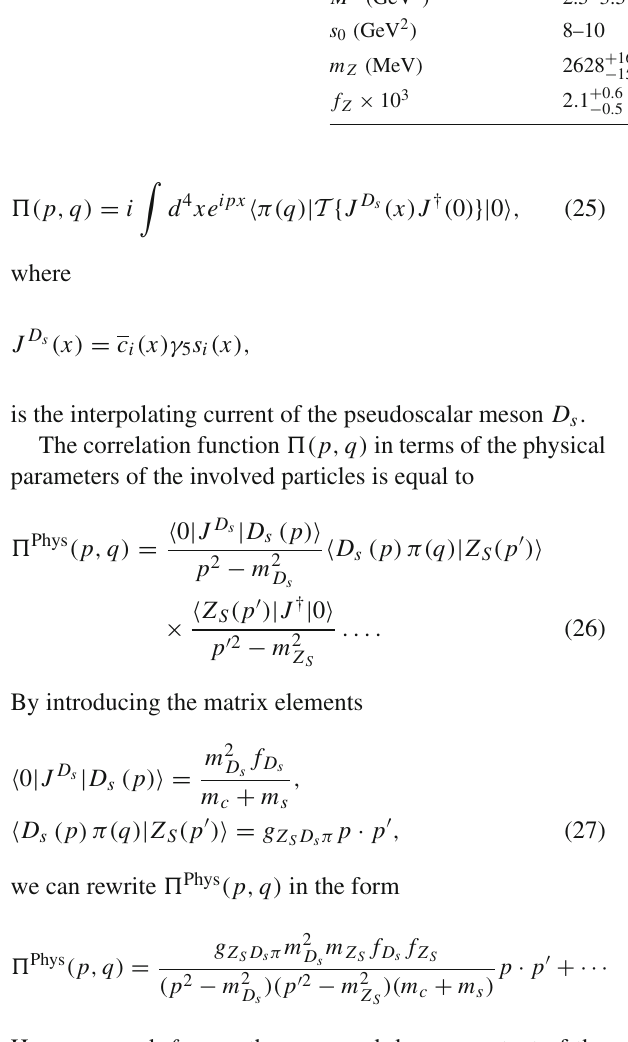
Fig. 10 The current coupling f Z (right panel) Table 1 The masses and current couplings of the Z S ,